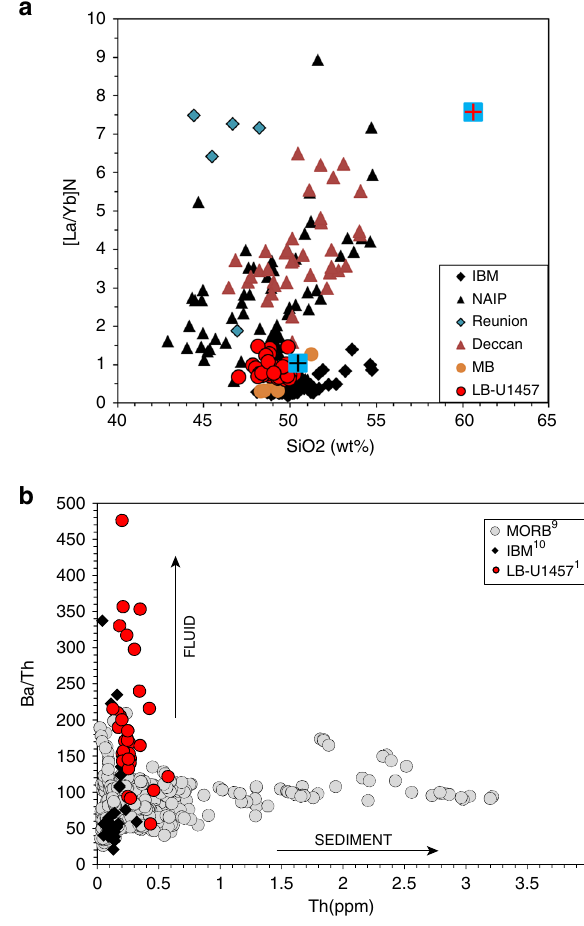
Fig. 2 Role of hydrous fl uids in LB lava. Characteristic geochemical diagrams. a Plot of chondrite normalized [La/Yb] N ratios vs. SiO 2 for different lava types. The black and red ‘ + ’ signs embossed in blue squares represent mid-ocean ridge basalt (MORB) 9 and bulk continental crust 4 ratios respectively. b Ba/Th vs. Th abundances for LB lava to evaluate role of hydrous fl uids versus sediments during subduction process. High Ba/Th values with low Th abundances are widely attributed to preferential mobilization of large ion lithophile elements (LILEs e.g., Ba) through hydrous fl uids components (vertical array) as opposed to the sediment fl ux (horizontal array) from the downgoing slab. IBM: Izu-Bonin-Mariana; NAIP: North Atlantic igneous province; MB: Muslim Bagh. (See Pandey et al. 1 and Clift et al. 2 for various data